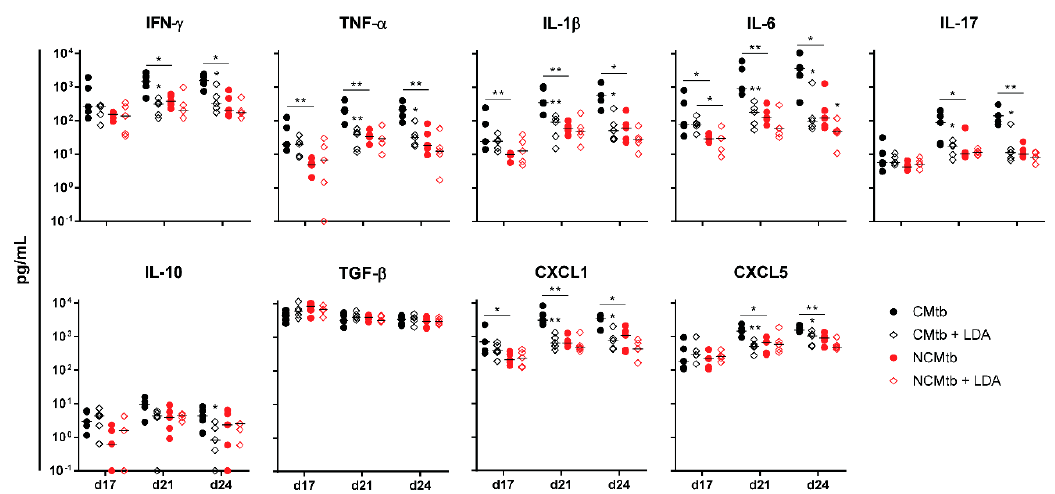
Figure 6. Impact of LDA infection in the immune response in lungs. Analysis of inflammatory mediators in lung homogenates at days 17, 21 and 24 PI. Results are represented as log10 of the concentration in pg / mL. Each circle represents an animal and lines are medians. Asterisks indicate di ff erences within the same batch; bar and asterisks indicate di ff erences between batches. Mann-Whitney test (* p < 0.05, ** p < 0.01).